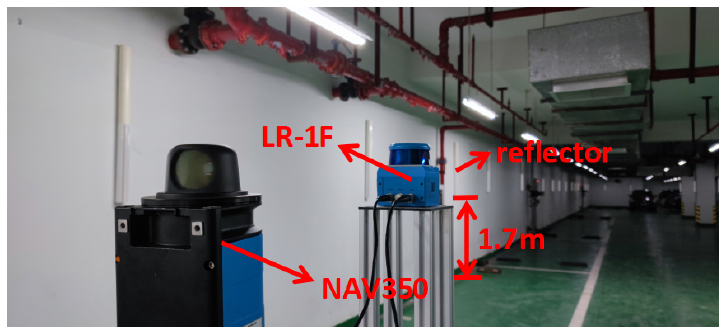
Figure 15. The platform and environment of the experiment. The height of LR-1F was set to 2 m and NAV350 was slightly lower than that of LR-1F. The experimental environment was an L-shaped underground garage about 50 m long and 5 m wide. The reflectors were randomly suspended on the wall with a height of 1.7 m.